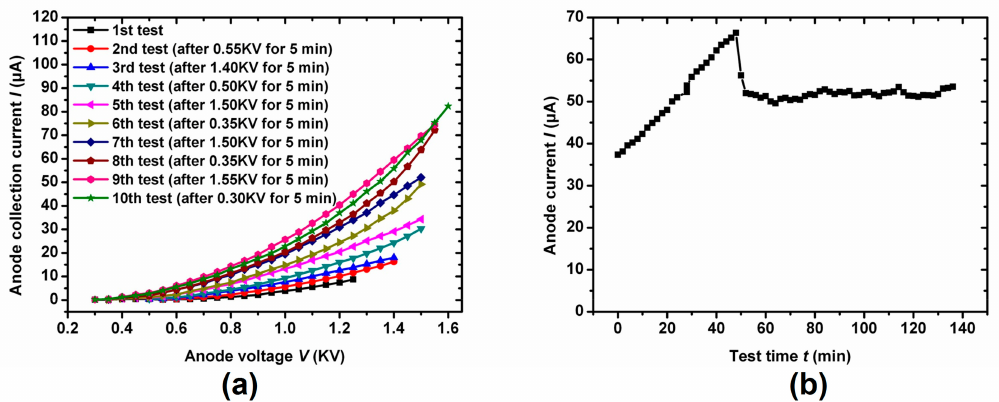
Figure 5. Field emission stability of ZnO nanomaterials. ( a ) Current-voltage plots of the field emission from ZnO nanomaterials for the 10-times cyclic test. ( b ) Stability test results of field emission